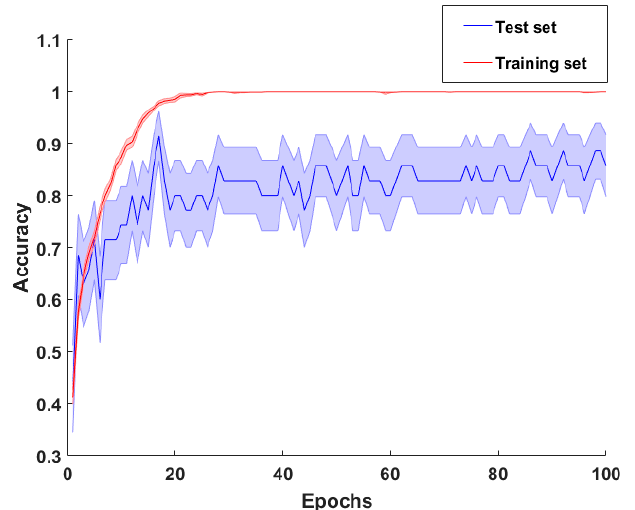
Figure 8. DCNN average (and related standard error) cross ‐ validated accuracy as a function of the training epoch for the training and the testing set, respectively. With respect to the feature-based analysis, performed by using the SVC, an accuracy of 0.77 was obtained. The sensitivity and specificity values for each of the 3 classes analyzed are shown in Table 2. Table 2. Sensitivity and specificity of DCNN and SVC models on HC, SSc, and PRP participants’ classification.